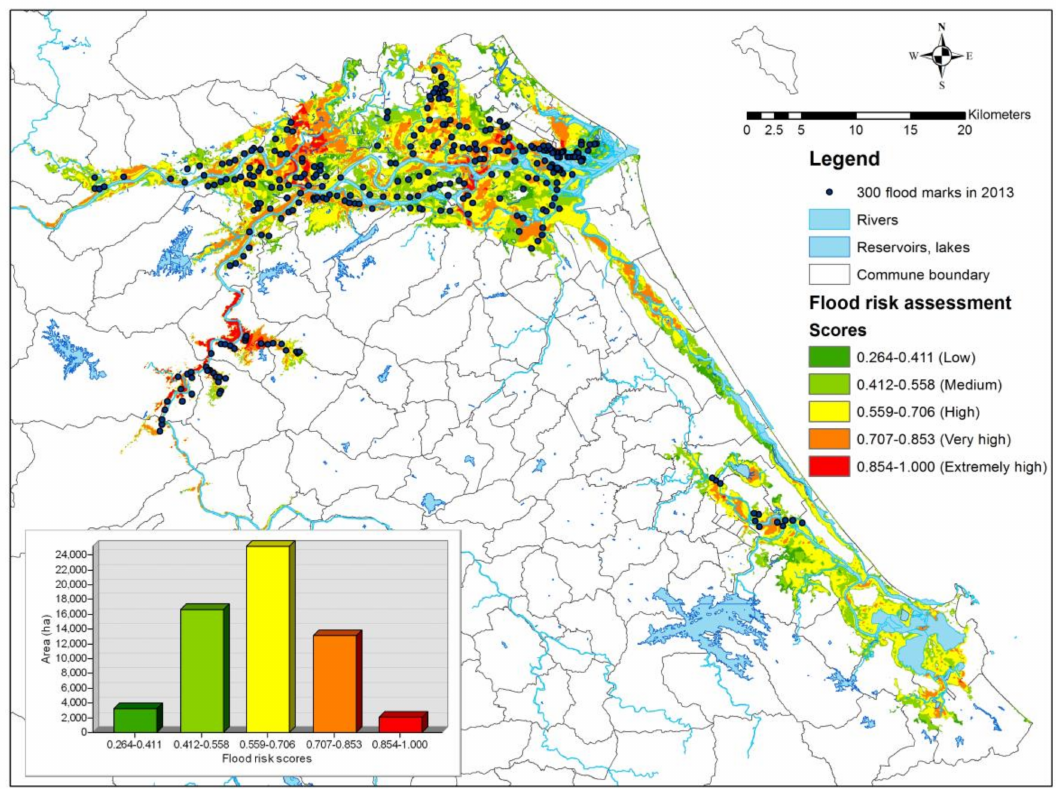
Figure 8. Spatial flood risk assessment of Quang Nam